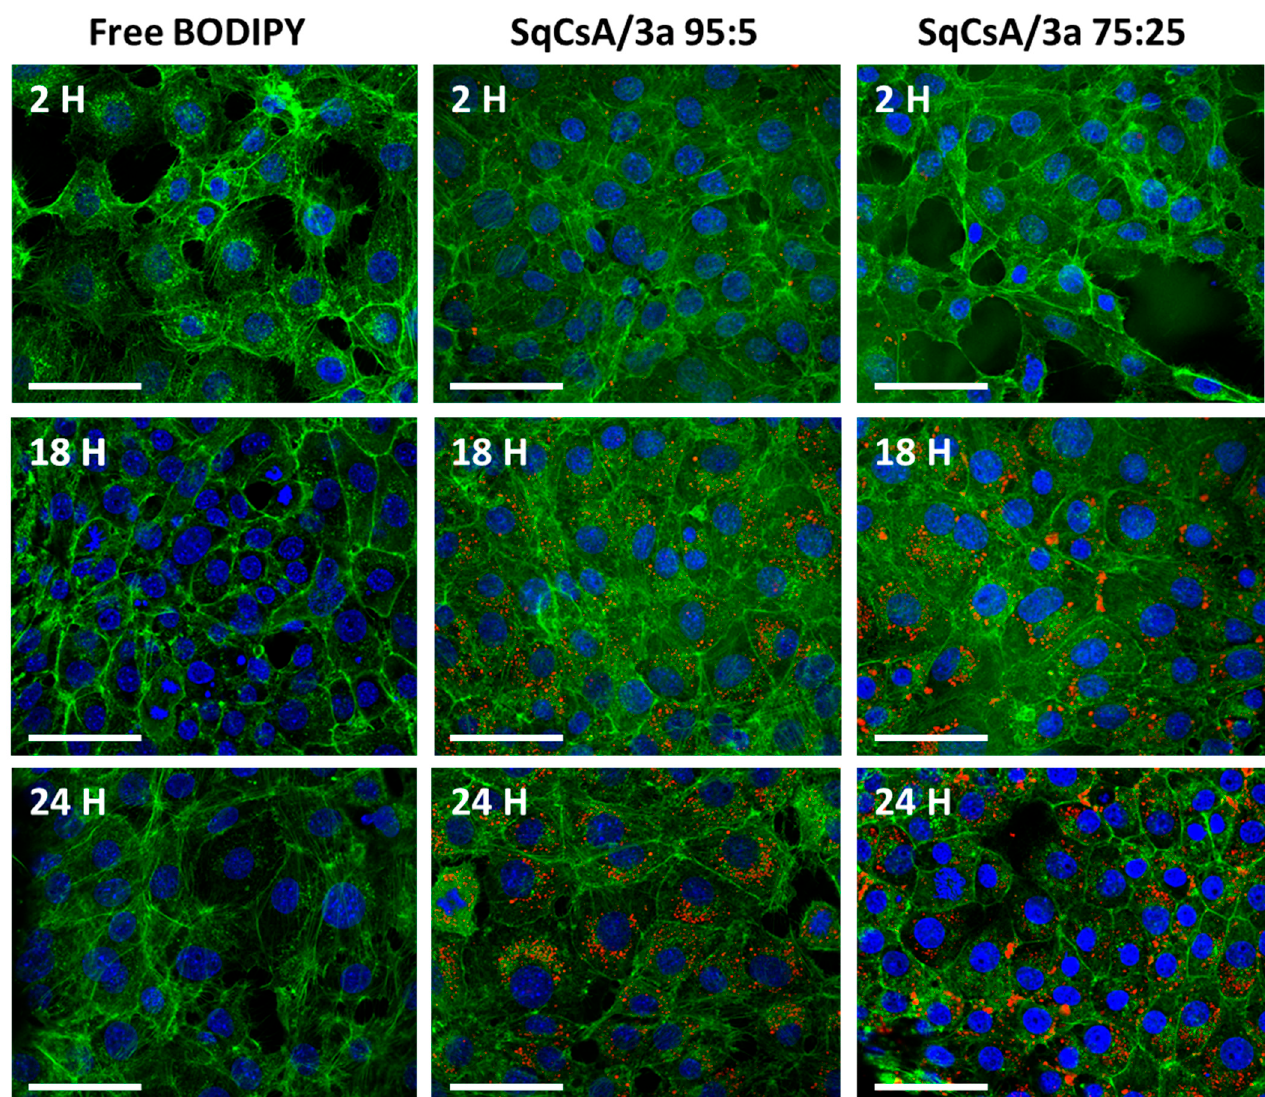
Figure 8. Uptake assessment of multidrug NPs by MCEC cells for two ratios (95:5 and 75:25). Cells incubated with only CholEsteryl BODIPY™, at an equivalent concentration to 30 µg/mL of NPs, were used as control and imaged at 2,18 and 24 h. Nucleus, actin filaments and NPs are represented, respectively, in blue, green, and red. Scale bar = 50 µm.